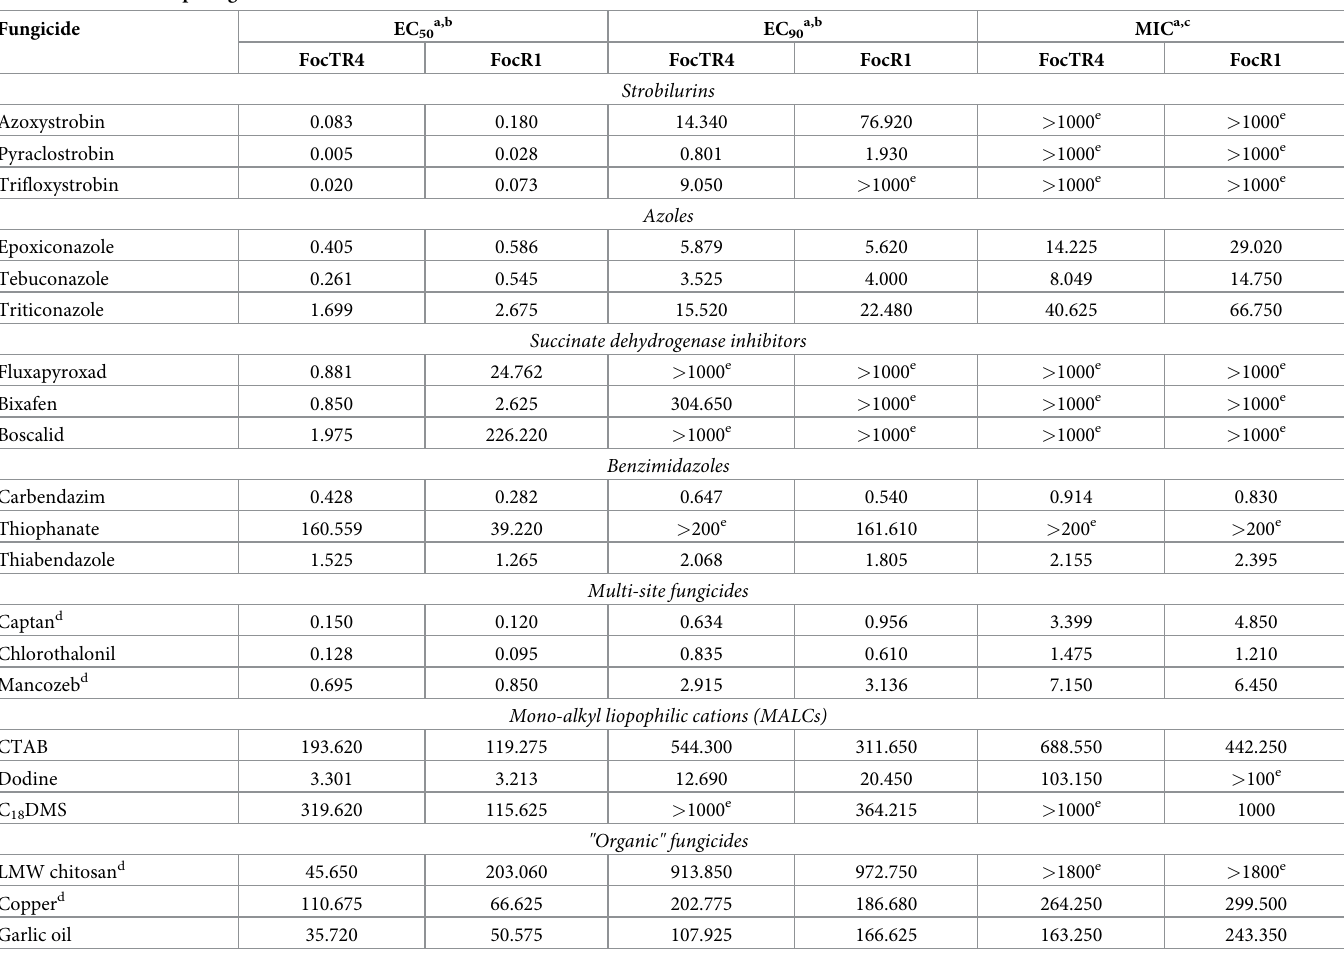
In the presence of several azoles, strobilurins and SDHIs, colony growth of FocTR4 and FocR1 was strongly inhibited at low concentrations. Paradoxically, sparse growth occurred at higher Table 1. Inhibition of plate growth of FocTR4 and